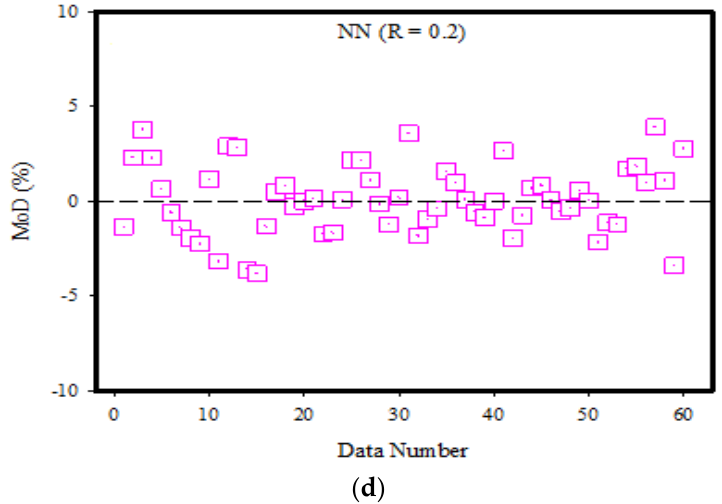
Figure 6. ( a ) The calculated MoD values for each data point without heat generation effect. ( b ) The calculated MoD values for each data point with generation effect. ( c ) The calculated MoD values for each data point without radiation effect. ( d ) The calculated MoD values for each data point with radiation effect.